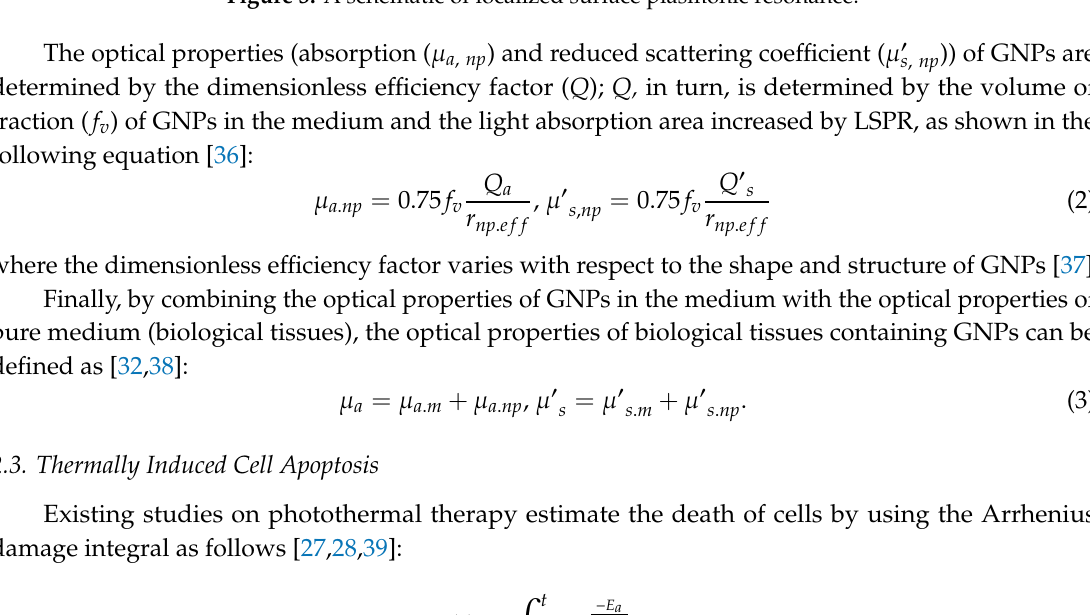
Figure 3. A schematic of localized surface plasmonic resonance.